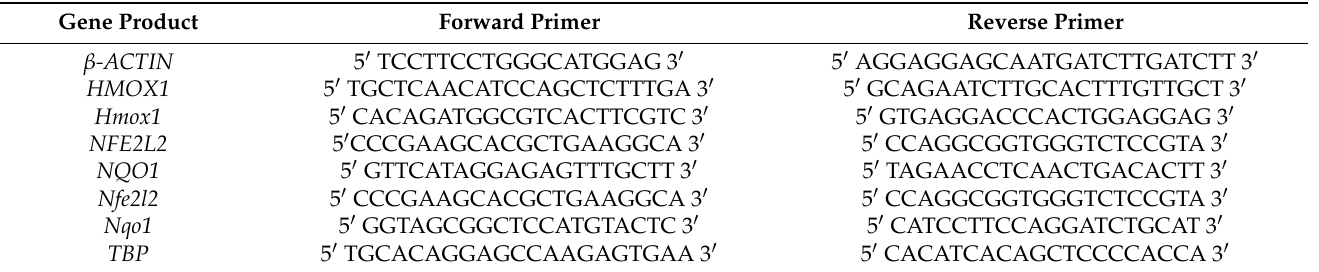
Table 2. List of primers used in this study. Gene Product Forward